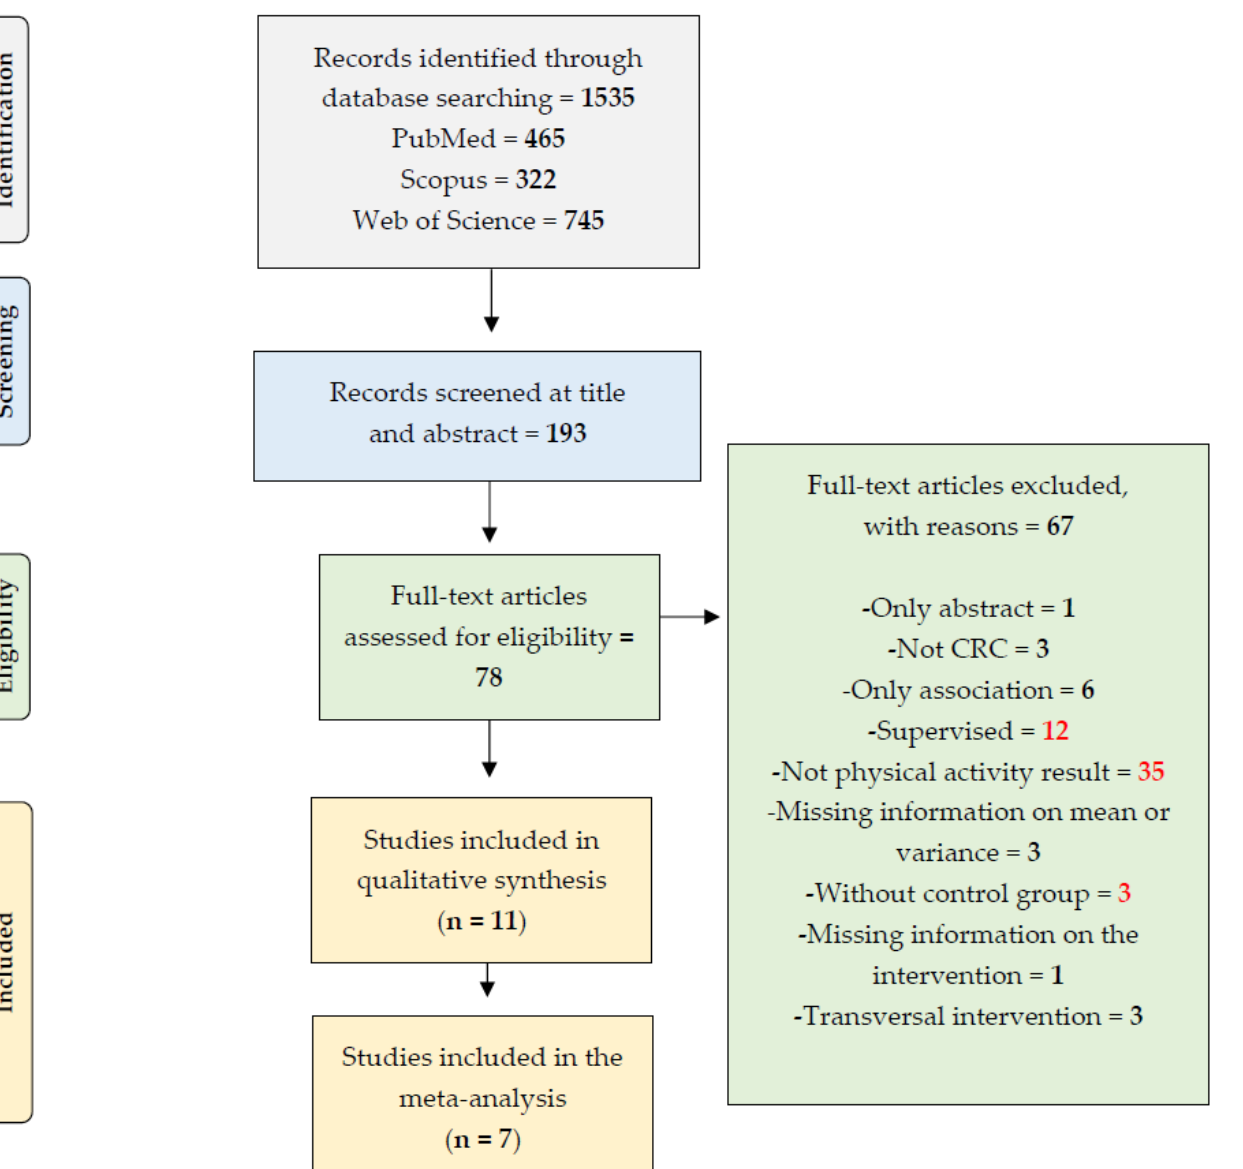
Figure 1. The Preferred Reporting Items for Systematic Reviews and Meta-Analyses (PRISMA) used to guide the systematic review.